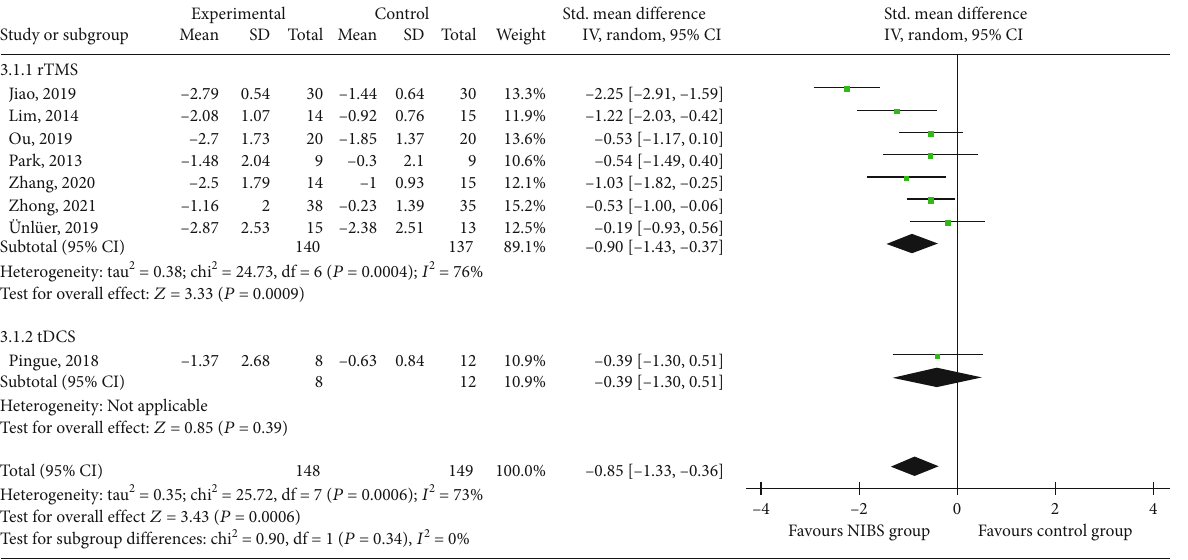
Figure 5: E ff ects of NIBS on PAS scores of patients with dysphagia after stroke.